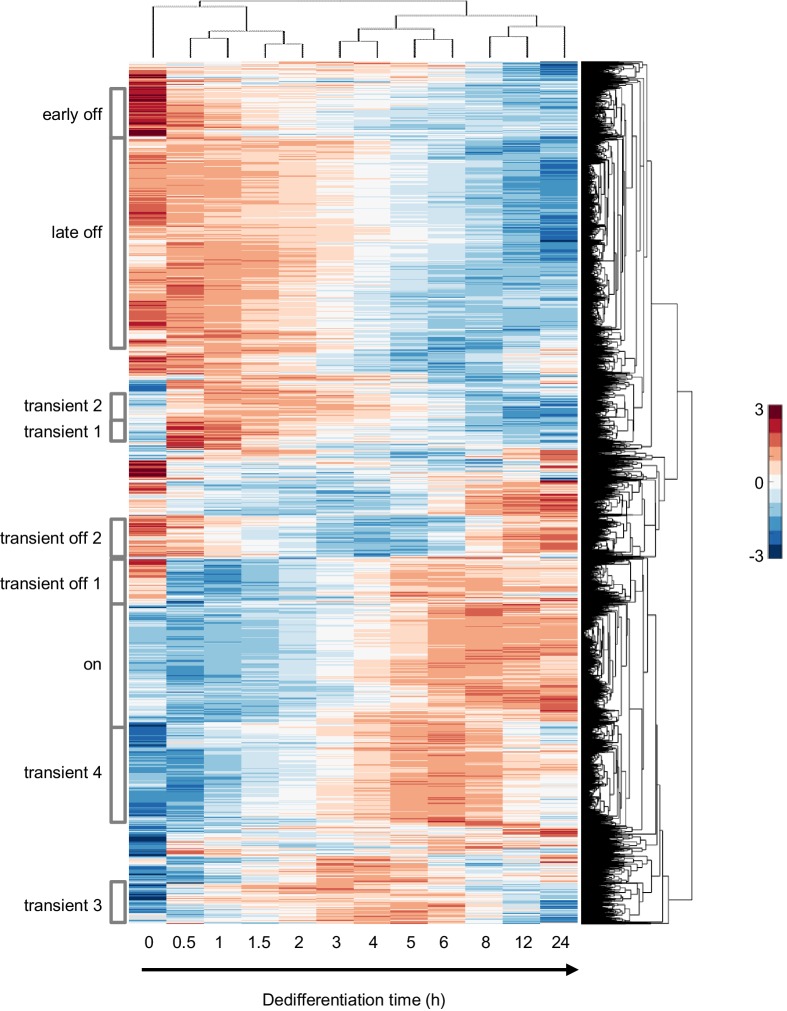
Different classes of gene expression profile during dedifferentiation.Two-way hierarchical clustering of gene expression changes during dedifferentiation on bacteria. The horizontal axis represents time during dedifferentiation and the vertical axis represents genes, with major branches in the clustering tree used as the basis to identify discrete clusters with specific dynamic trends: ‘early off’, ‘late off’, ‘transient 1–4’, ‘on’ and ‘transient off 1 and 2’. Colour indication based on z-score of log2 counts.